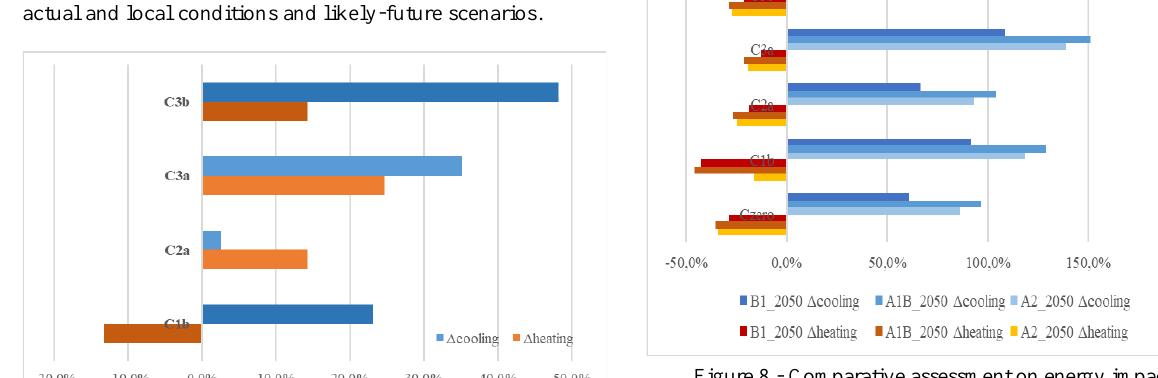
Figure 8 - Comparative assessment on energy